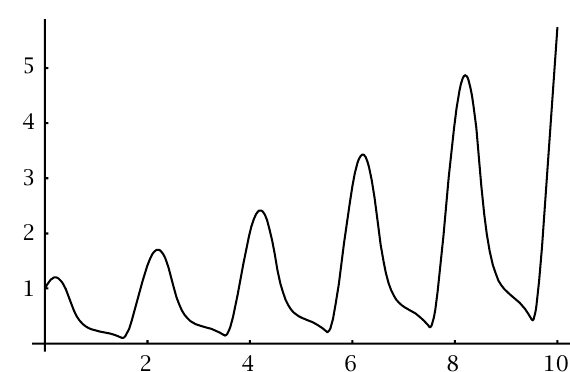
Figure 6.9 . T j (t) for b(t) = b cos (πt) , b = 3, d j = 3 .